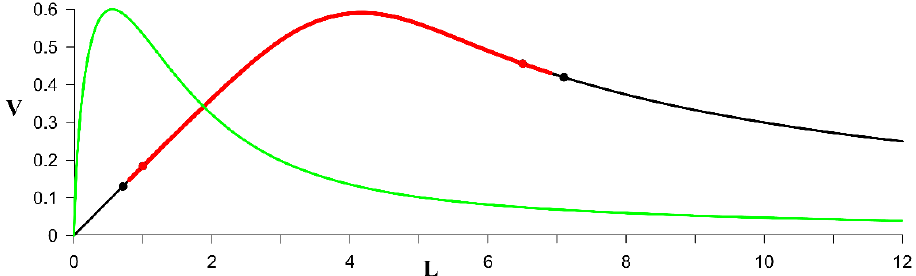
Figure 5. The translational velocity V vs. L of the vortex structure composed of the point vortices in upper and middle layers (green line) [19] and finite-area vortex patches in the same layers (black-red line) at r 1 = 4; P 1 = 0.6 and r 2 = 1; P 2 = − 0.6 on the distance L between vortices in the first case and their centers in the second case. The part of the curve in which the surface vortex loses its compactness and partially collapses is marked in red. Markers on the black ( L = 0.71, L = 7.00) and red ( L = 1.00, L = 6.50) lines correspond to the experiments presented in Figure 6.